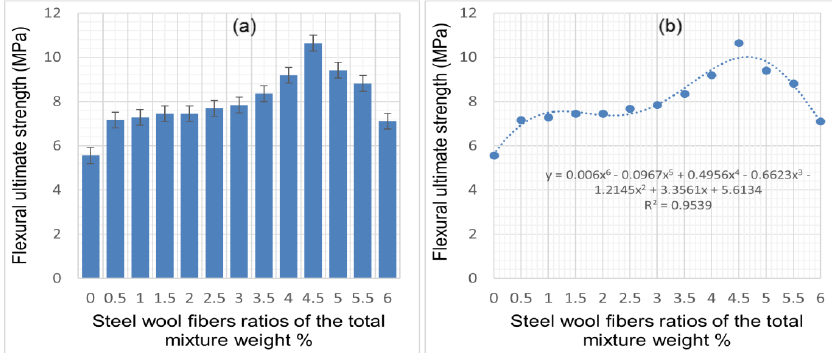
Figure 9. The flexural strength of cement mortar at various CSWF ratios: ( a ) flexural strength val- ues corresponding to the CSWF ratios, ( b ) correlation between flexural strength and CSWF addi-